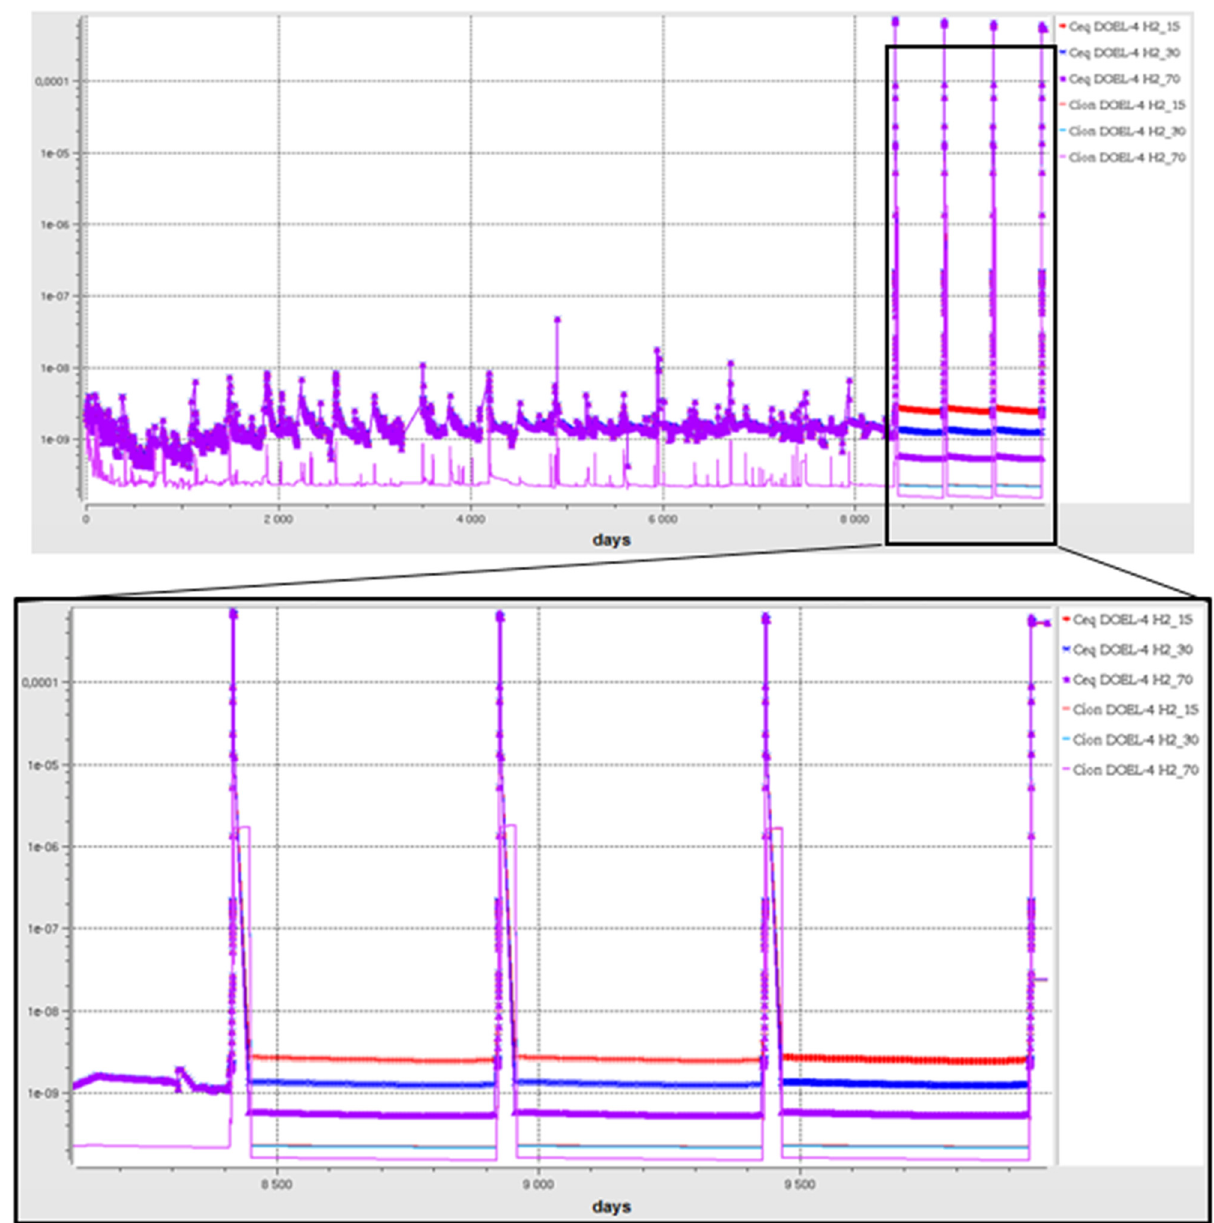
Fig. 9. OSCAR V1.3 calculation (cid:2) Comparison between Ni equilibrium concentrations in solution (Ceq) and Ni concentrations in solution (Cion) inside the SG cold side